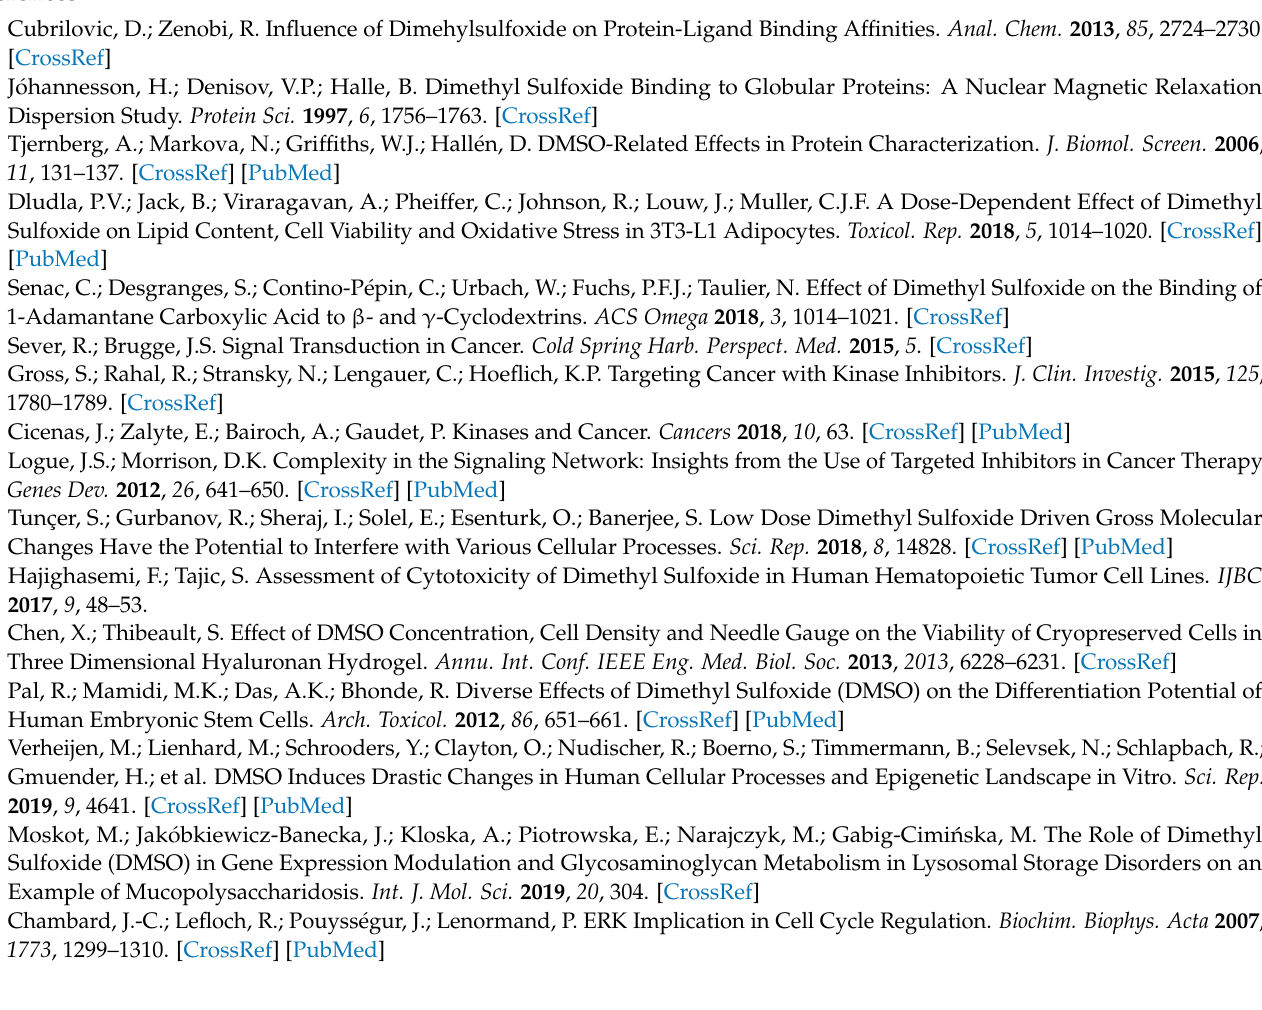
Table S4: List of antibodies used for the RPPA analysis including target proteins, vendors, catalogue numbers, and